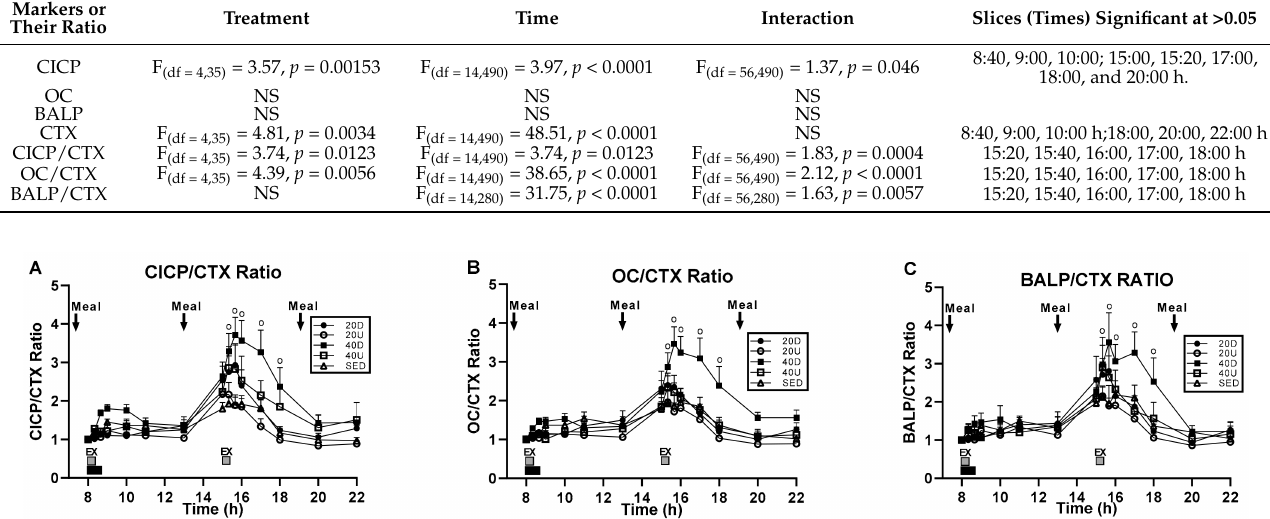
Figure 4. Changes in the ratios between the three markers of bone formation and the marker of bone resorption. CICP/CTX ratio ( A ) was significantly higher for 40 Down than for SED and 20 Up groups, and OC/CTX ratio ( B ) for 40 Down than for SED, 20 Up, and 40 Up groups. BALP/CTX ratio ( C ) were only significant difference between groups at time slices after the second exercise bout.“o” marks time slices of significant group